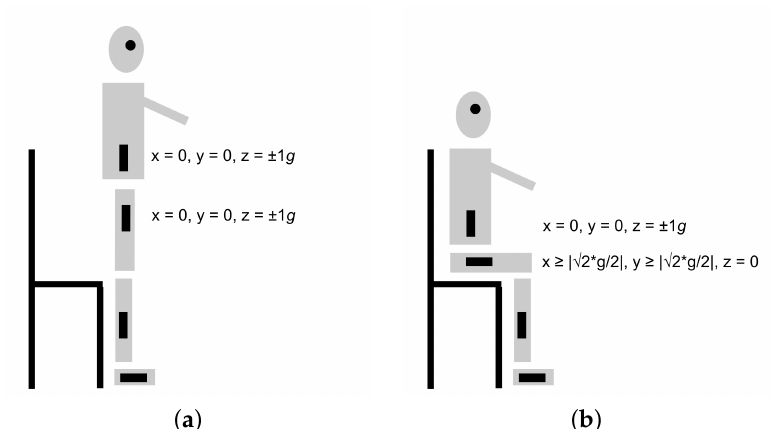
Figure 2. TUG: accelerometer data for thigh and torso in the standing and sitting positions. ( a ) Sensor values when standing. Both sensors are in the vertical position. ( b ) Sensor values when sitting. The thigh sensor is in the horizontal